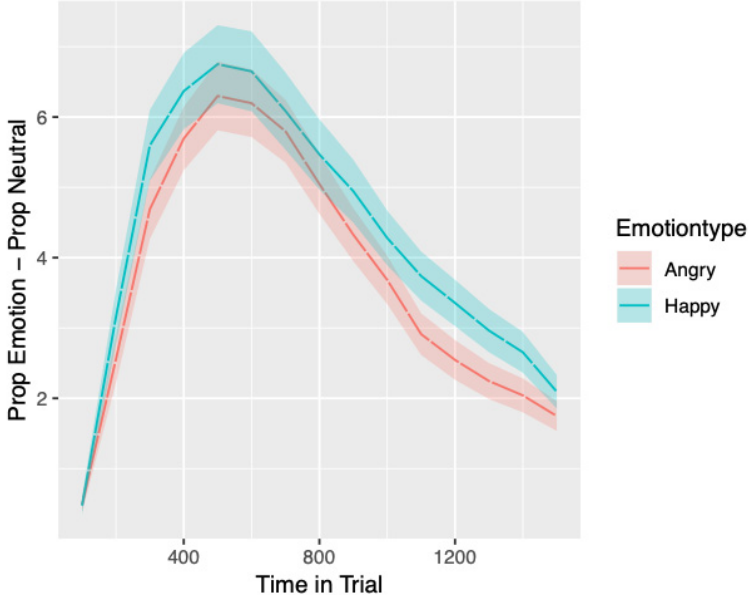
Figure 3. Time course of bias to emotional faces averaged over trials, split by emotion type. Standard errors in the proportion of looking to Areas of Interest (AOIs) can be seen as shaded areas surrounding the lines denoting emotion type.